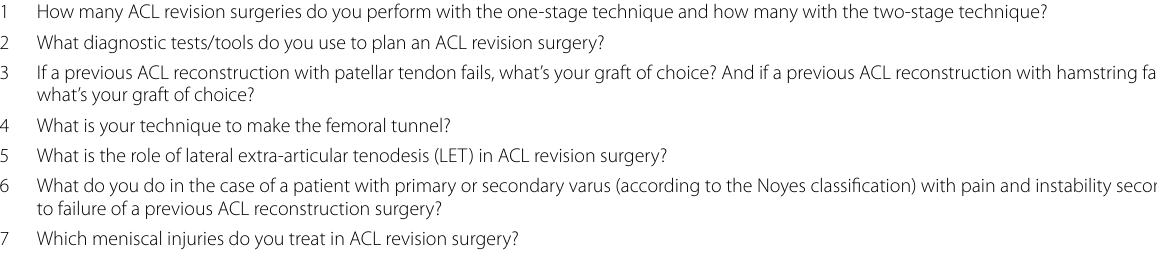
Table 2 List of the